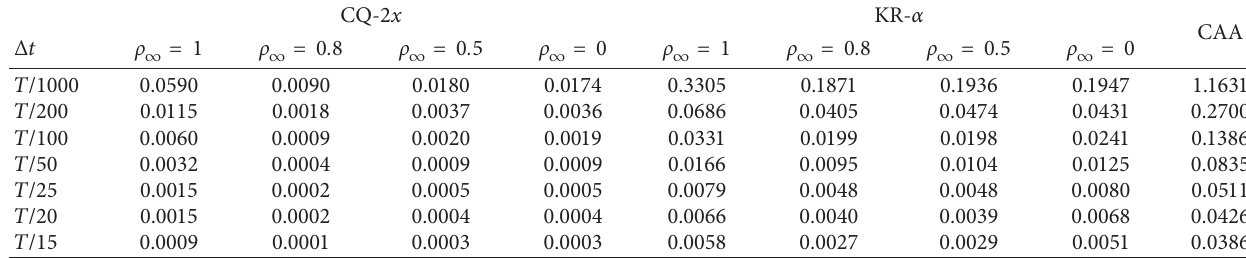
Table 2: Time consumptions of the different algorithms for solving the Duffing vibration problem in Example 2 over a time duration of 100 T (unit: second).